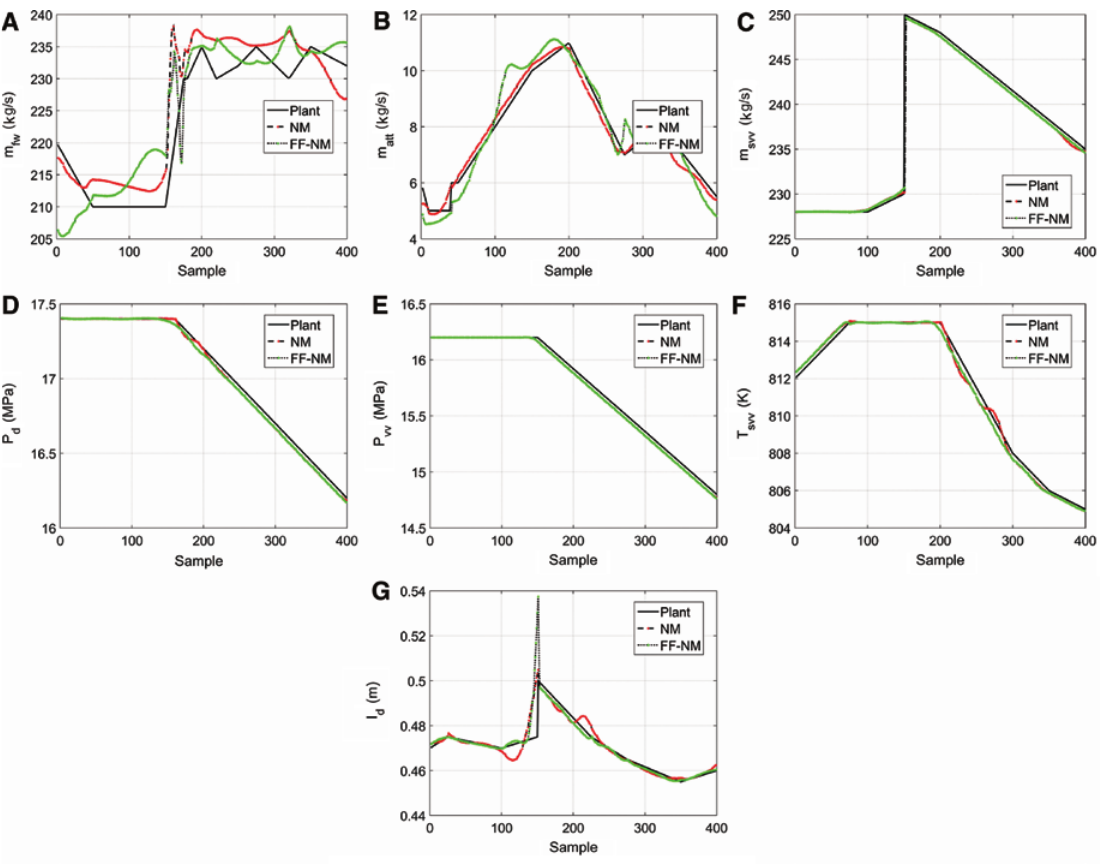
Figure 6: Correlation between the Output of Different Models from Test Case 2 – Set